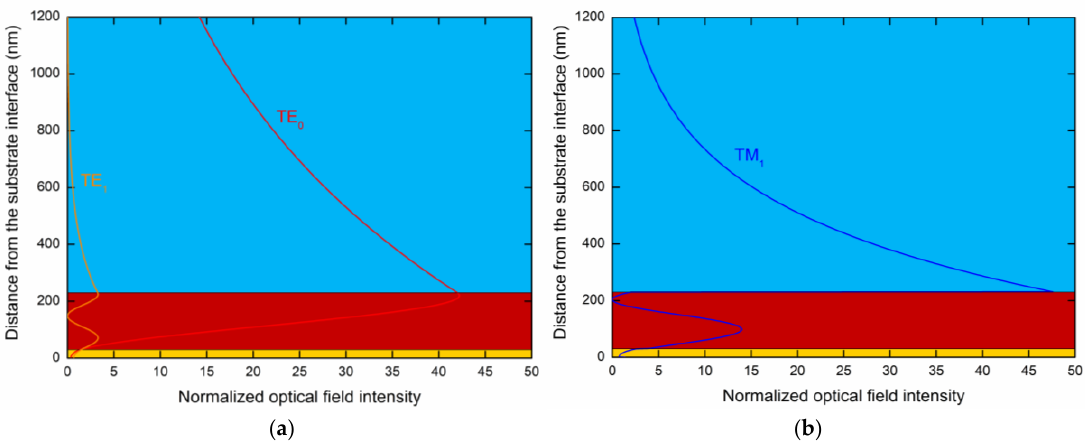
Figure 6. The normalized optical field intensity distribution in the PWS for the angle of incidence θ = 42.2 ◦ and for the wavelength ( a ) with λ = 536.9 nm exciting the TE exciting the TE 0 mode, and ( b ) λ = 726.3 nm exciting the TM 1